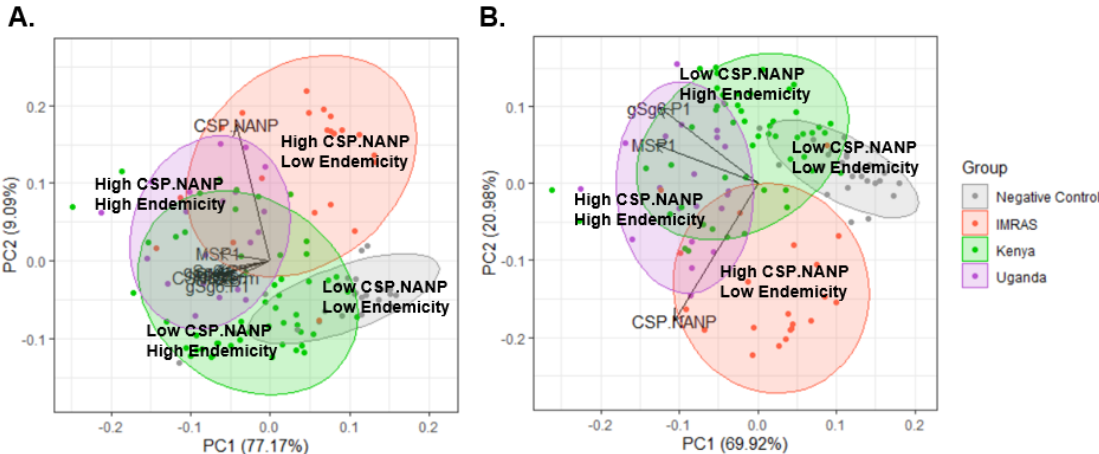
Figure 5. Serological profiles of endemic malaria exposure. ( A ) PCA using all antibody responses to all eight antigens for samples from negative controls (gray), IMRAS (red), Kenya (green, moderate transmission intensity), and Uganda (high transmission intensity). ( B ) PCA using antibody responses to a subset of three antigens that showed a significant difference following CHMI in clinical studies. Areas of the PCA plot that correspond to low and high CSP.NANP responses and low and high endemicity markers are shown.